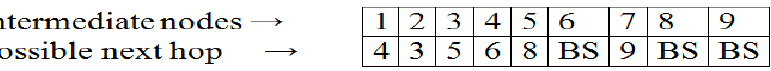
Figure 4. Chromosome representation for multipath.